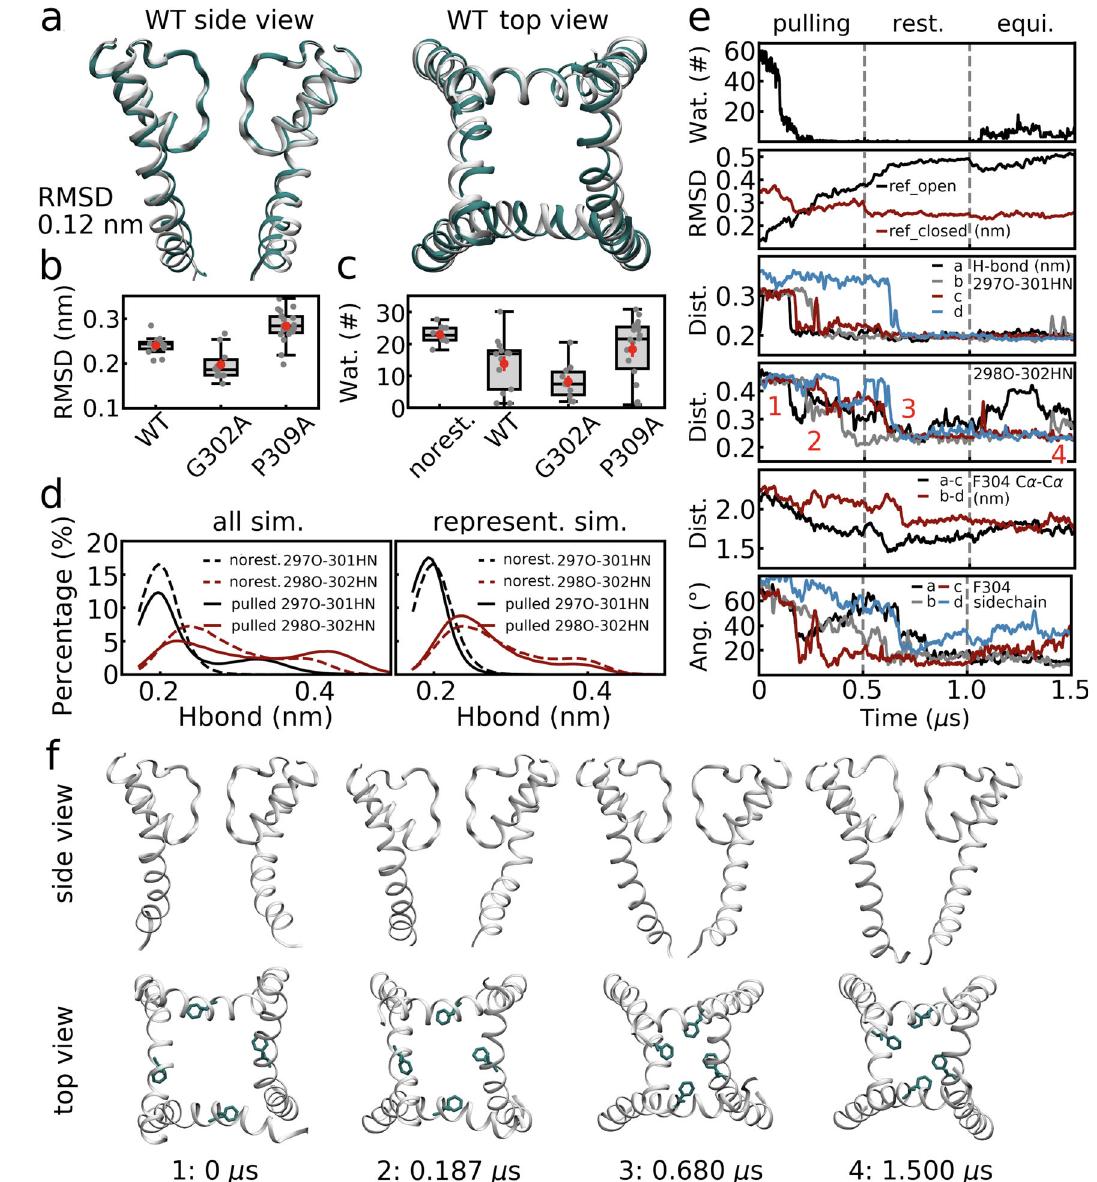
Fig. 4 | Enforced cavity dehydration induced conformational transition from the open to closed state. Comparison of the closed conformation (wild type) in non-equilibrium and equilibrium simulations. a The average structureforall ofthe enforced dehydration simulations (cyan) is aligned to that of the equilibrium simulationsoftheclosedstate(white). b BoxplotoftheRMSDvalues.TheRMSDof the average structure for each of the non-equilibrium simulation was calculated relative to the average structure of corresponding equilibrium simulations. c Boxplot of the numbers of water molecules in the cavity in non-equilibrium simulations. Results of the equilibrium simulations of the wild type ( “ no rest. ” ) are alsoshownforcomparison.In( b , c ),resultsofthewildtype( n =13)andtheG302A ( n =10),P309A( n =19)mutantsareshown.Thecenterline,boxlimits,andwhiskers represent the median, upper and lower quartiles, and 1.5×interquartile range. The datapointsareshowningraydots,whiletheaveragesanderrors(standarderrorof themean,s.e.m.)areshowninred. d